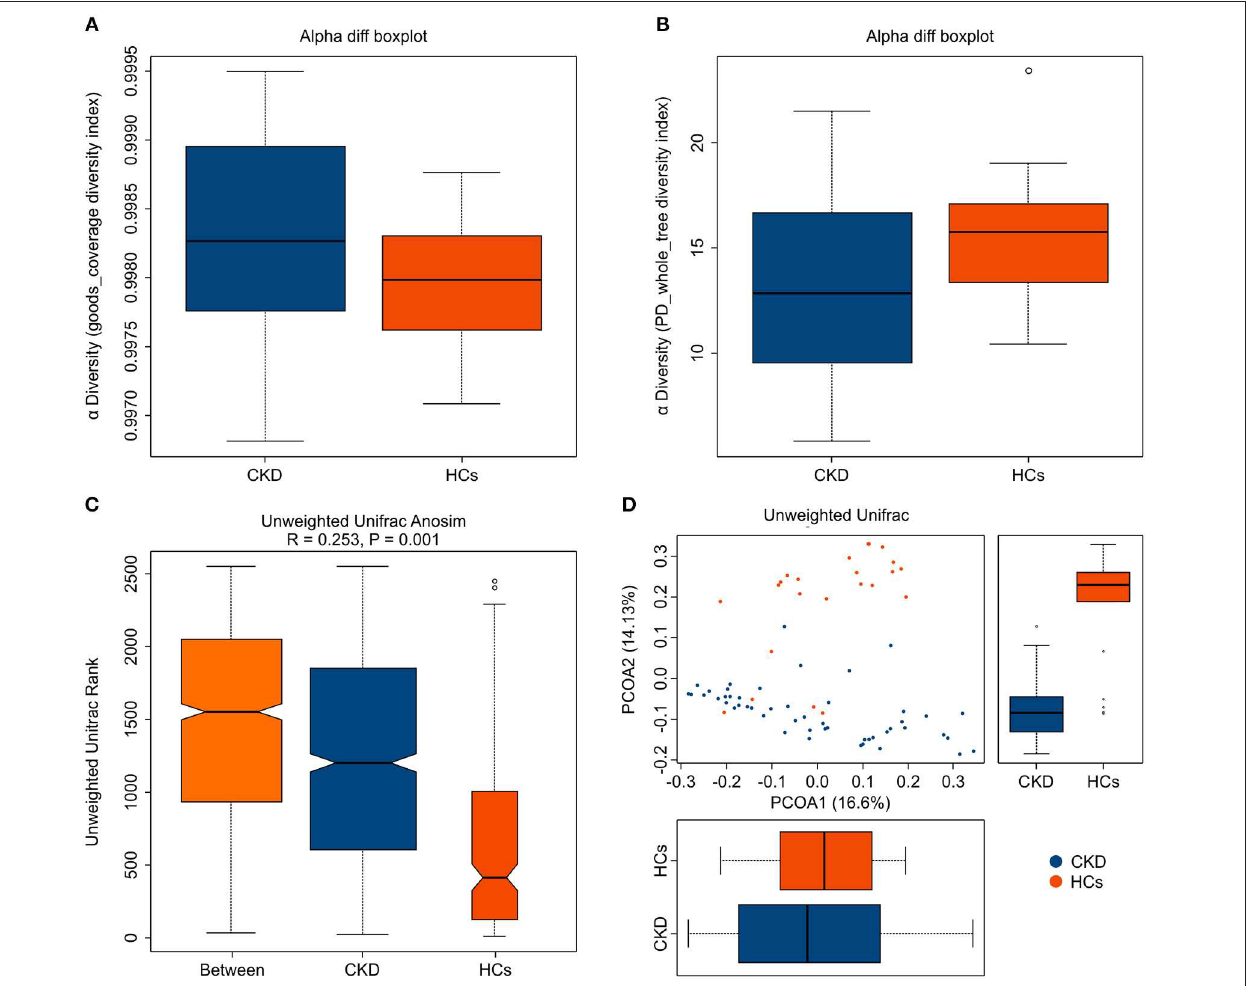
FIGURE 1 | Fecal microbiota alpha- and beta-diversity in patients with chronic kidney disease (CKD) and healthy control (HC) subjects. The depicted box plots show differences in the fecal microbiome diversity indices between the CKD and HC groups, as assessed using (A) Goods coverage diversity and (B) Phylogenetic Diversity (PD) whole-tree indices. Each box plot represents the median, interquartile range, minimum, and maximum values. (C,D) The level of similarity between the fecal microbial communities detected in the CKD (blue) and HC (orange) groups was assessed via (C) an unweighted Analysis of similarity (ANOSIMs) and (D) a principal coordinates analysis (PCoA; based on the UniFrac distance matrix). Respective ANOSIM R values show community variation between the compared groups, and significant P -values are indicated. Each symbol represents a